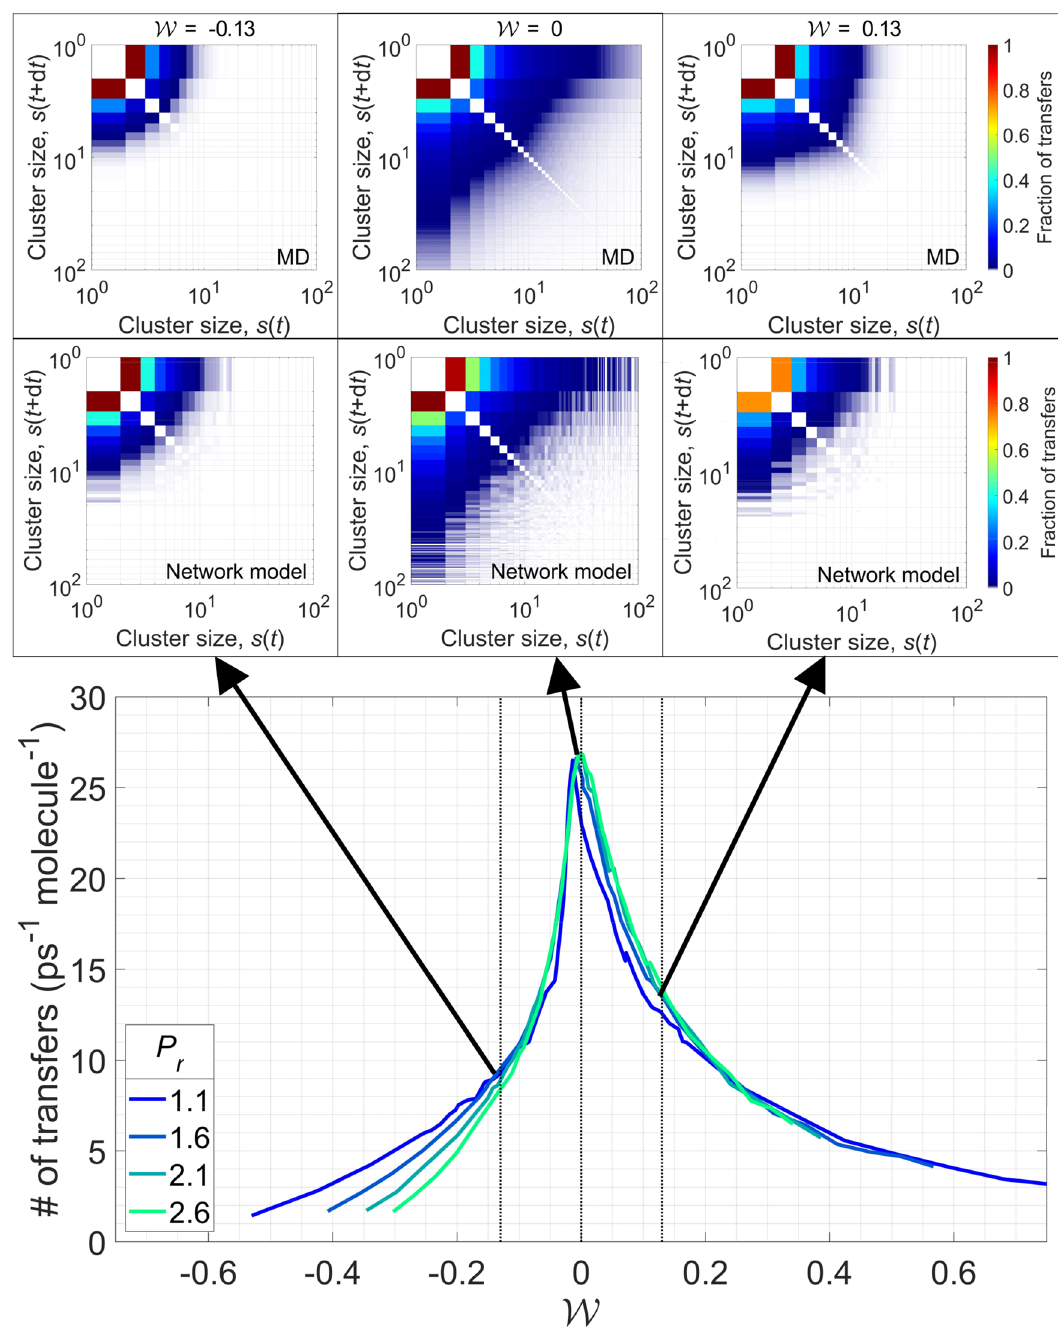
Fig. 7 | Molecular transfers between clusters. Molecular transfers rate peaks along the Widom line. (inset) Transfer matrices (with time increment dt =2.5 ps) show that molecular exchanges are localized at a given scale: largest cluster in the liquid-like state ( W = (cid:2) 0 : 13) and small clusters in the gas-like state ( W =0 : 13).